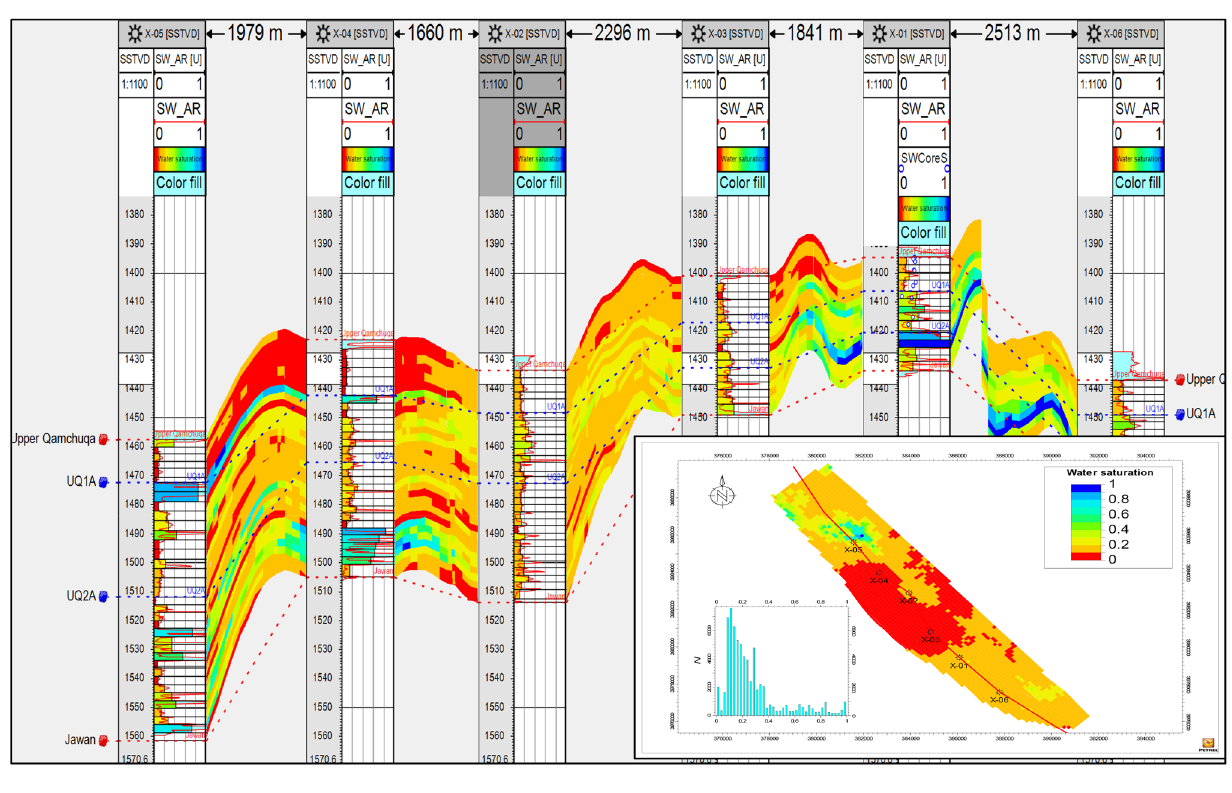
Fig. 5 Water saturation model